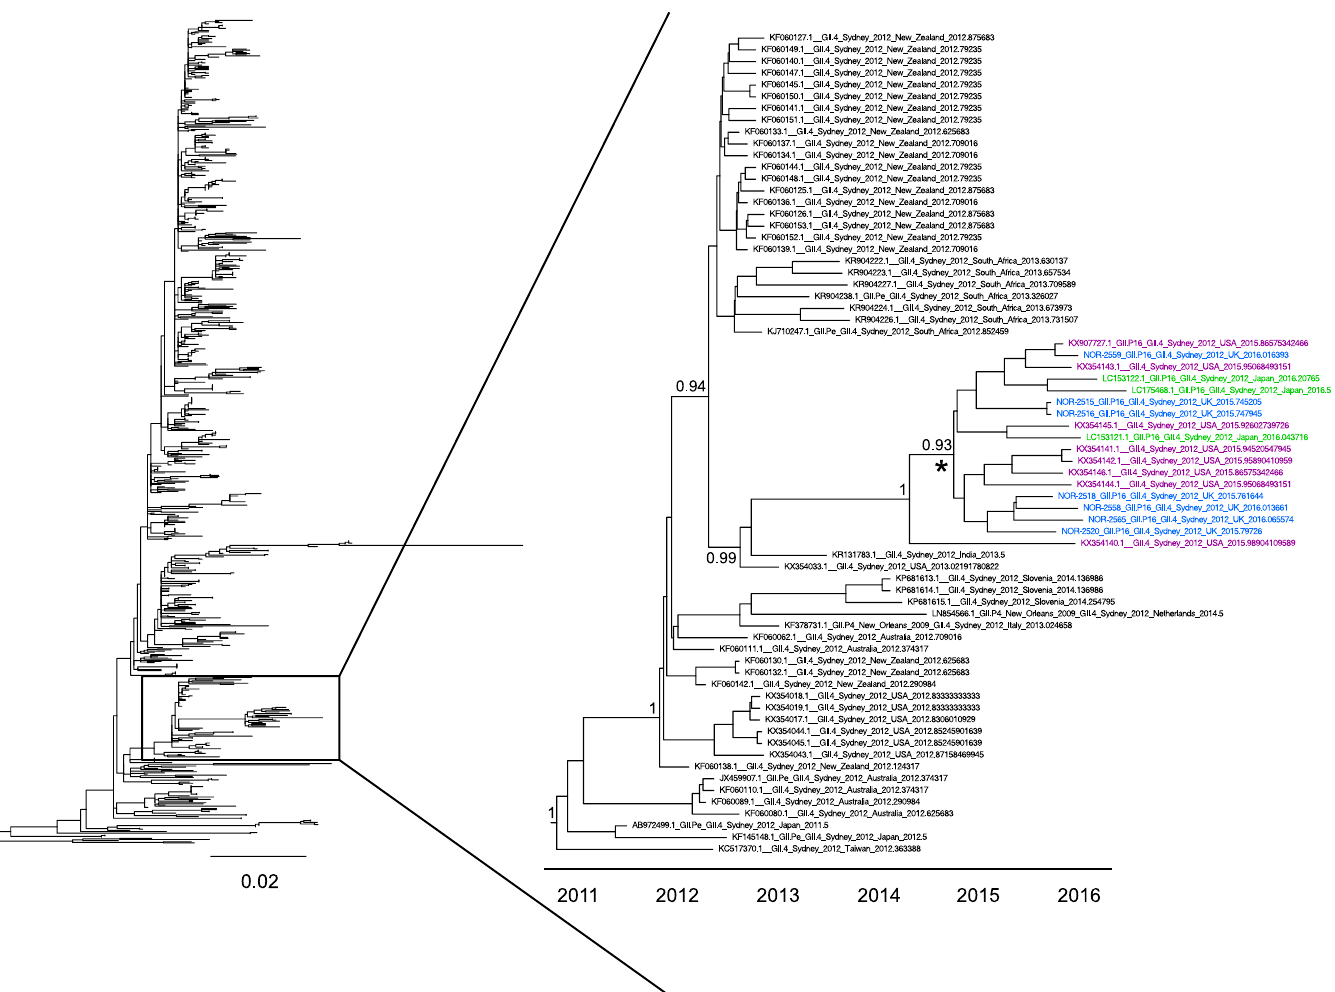
Fig 2. Evolutionary history of the GII.4 Sydney 2012 capsid. A maximum likelihoodtree was reconstructed for 781 GII.4 Sydney 2012 capsid samples. From this, a well supported clade (bootstrap support 81) containing the GII.P16-GII.4 Sydney 2012 lineageand severalother samples was selectedand a time tree reconstructed on this smaller dataset using BEAST 2. The starred node is the common ancestor of the GII.P16-GII.4 Sydney 2012 lineageand the samplesin this lineageare colouredbasedon the country from which they were isolated:blue—UK, purple—USA, green—Japan. Posterior supports are shownat key